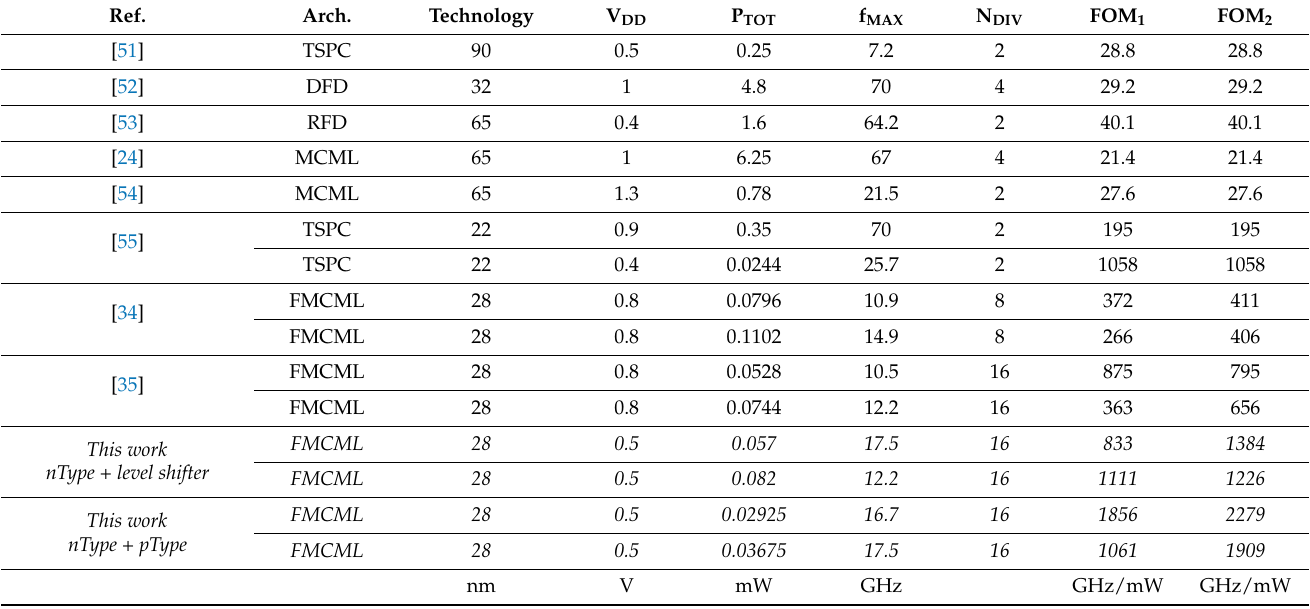
Table 7. Comparison with the